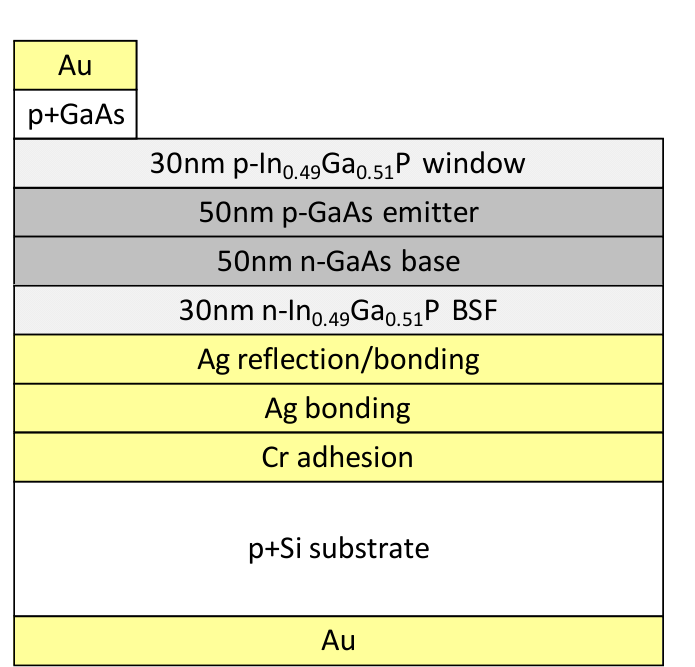
Figure 18. Schematic cross-sectional diagram of the waveguide-like GaAs solar cell with metal back